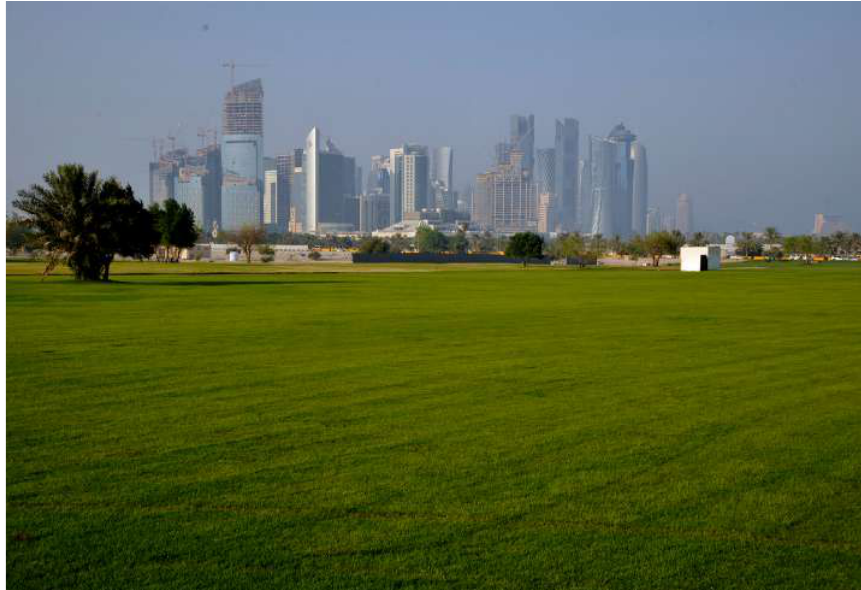
The Emerald City (Source: Peter Chomowicz,